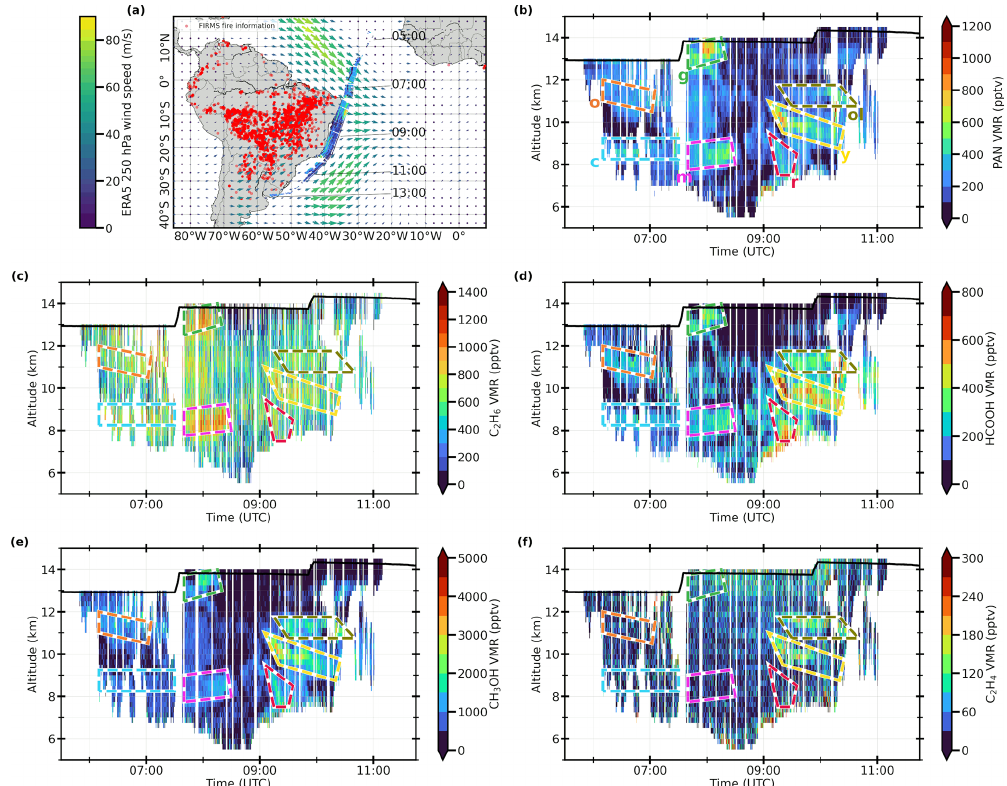
Figure 1. (a) Flight path for SouthTRAC research flight on 8 September 2019 from Sal, Cabo Verde, to Buenos Aires, Argentina. Along the flight track, concentrations of PAN are displayed at the horizontal distributions of the tangent points (color bar in b ). The temporal evolution of the flight is indicated by times in UTC, marked along the flight track. Fire events as noted by FIRMS during 3d before the GLORIA measurements are indicated as red dots on the map. ERA5 horizontal winds at 08:00UTC at a typical measurement altitude of 250hPa (approximately 10km) are shown as arrows with amplitudes given by the left color bar. (b) Vertical distribution of GLORIA measurements of PAN for SouthTRAC flight on 8 September 2019. The black line marks the aircraft altitude. Colored boxes mark air masses of interest, which are discussed in more detail by a trajectory analysis in the following section (o: orange, c: cyan, g: green, m: magenta, ol: olive, y: yellow, r: red). (c) Same as (b) , but for C 2 H 6 . (d) Same as (b) , but for HCOOH. (e) Same as (b) , but for CH 3 OH. (f) Same as (b) , but for C 2 H 4